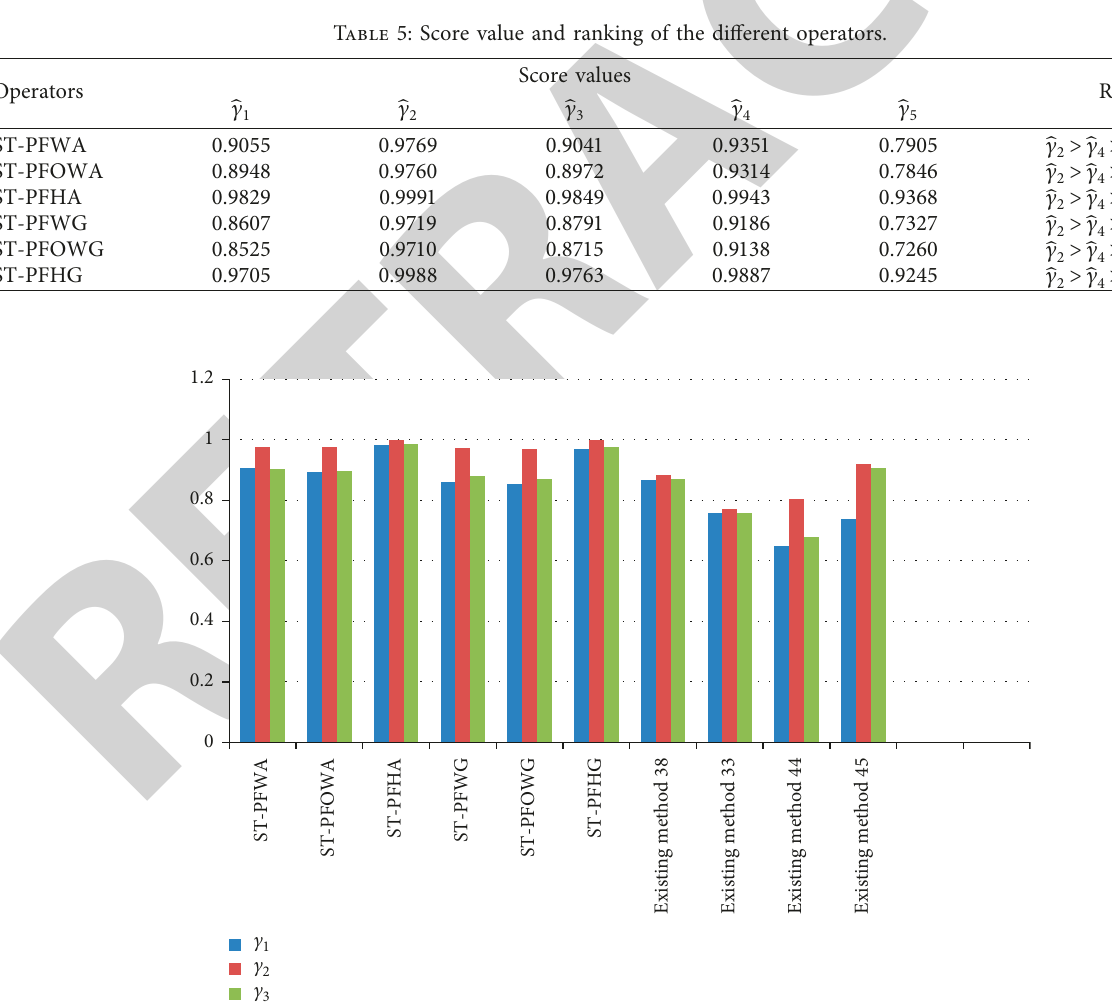
Figure 1: Graphical representation of the obtained results using different proposed